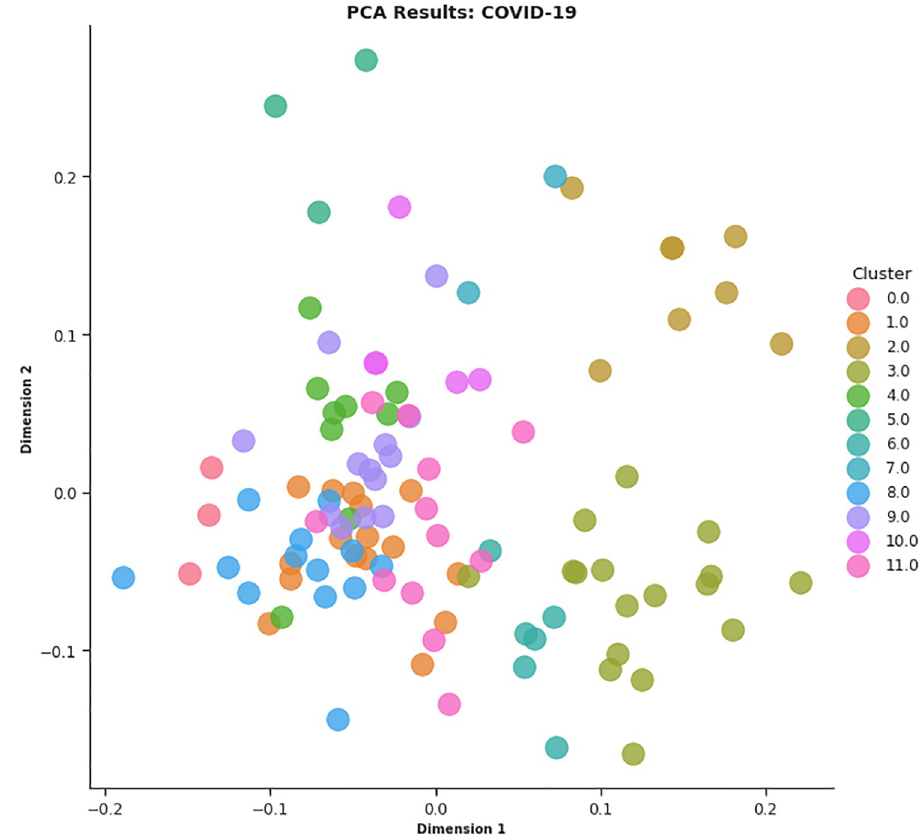
Fig 28. PCA visualization of clusters for